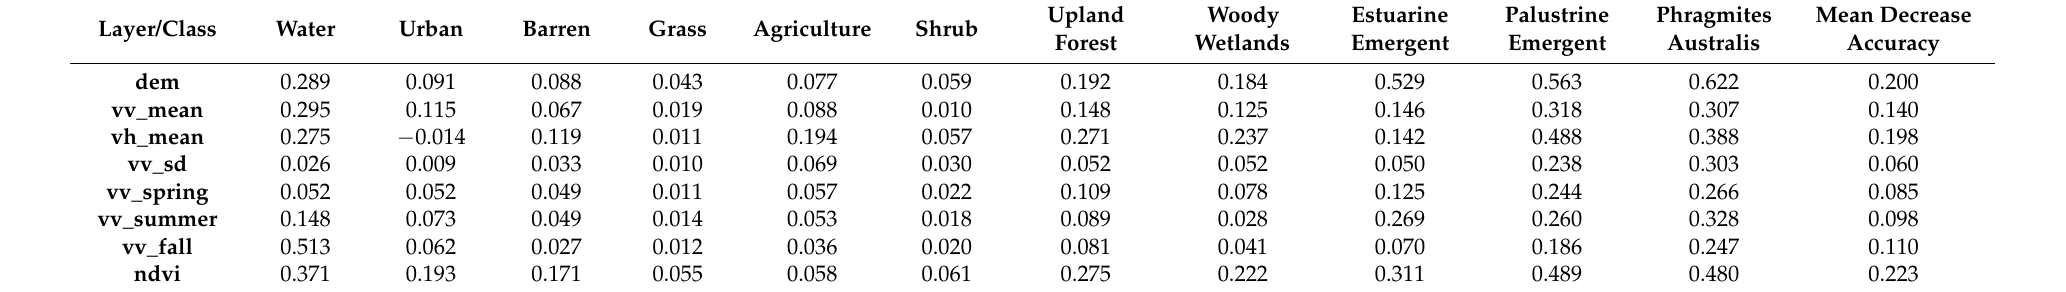
Table 4. Mid-Atlantic level-1 random forest classification importance assessment. In this table, vertical columns 2–12 with specific classes represent the decrease in accuracy identifying that class when an input data layer in column 1 is removed from the classification. The ‘Mean Decrease Accuracy’ column shows the effect of removing an input data layer averaged across classes.